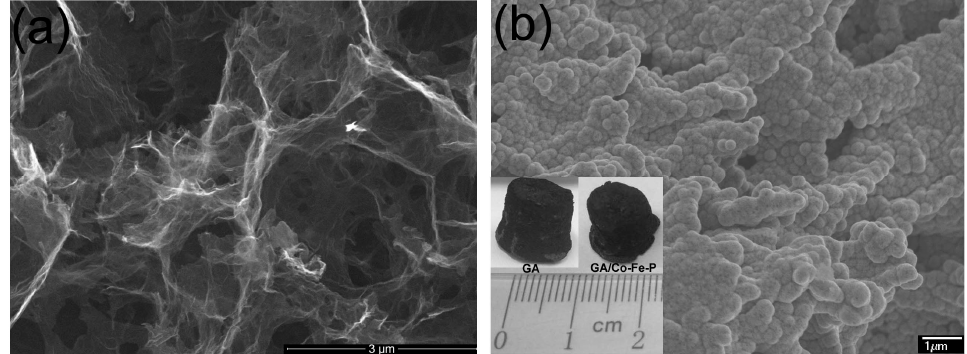
Figure 1. SEM images of GA ( a ) and GA/Co-Fe-P (Sample-h14) ( b ). The inset in ( b ) shows the typical size and shape of GA and GA/Co-Fe-P samples.